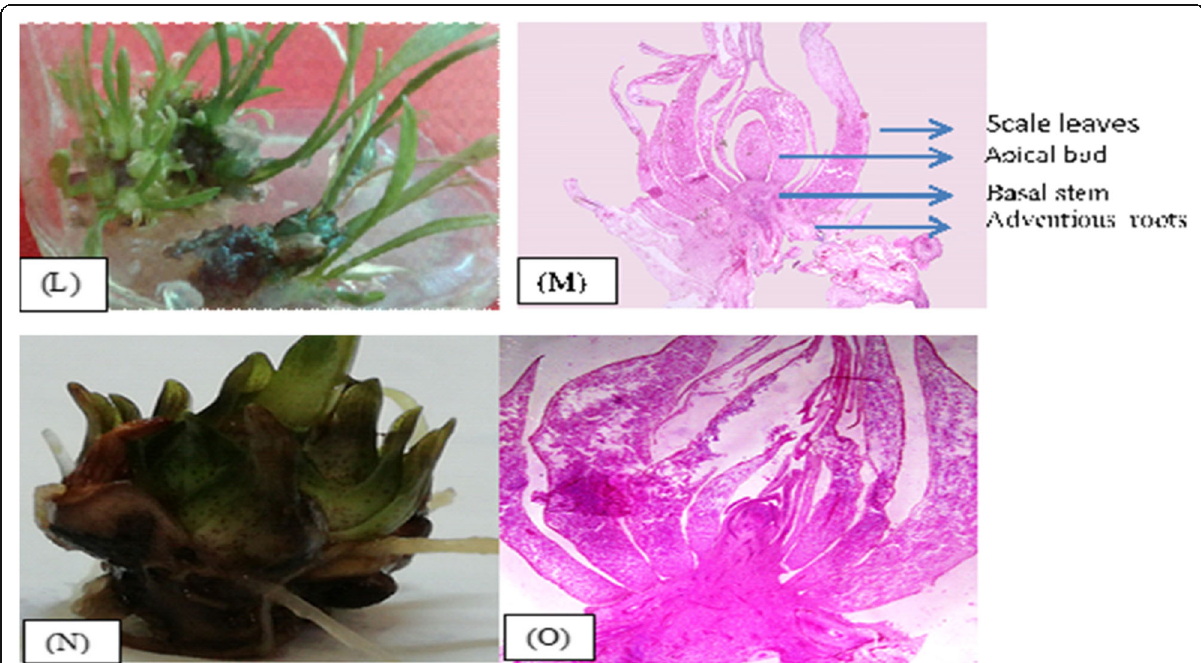
Fig. 7 Bulblet formation during the third subculture. l , m Bulblets formed on MS medium supplemented with 30 g/l sucrose + BA 1.0 + NAA0.2 mg/l (control). n , o The acclimatized bulb from MS medium with 120 g/l sucrose + paclobutrazol at 6 mg/l